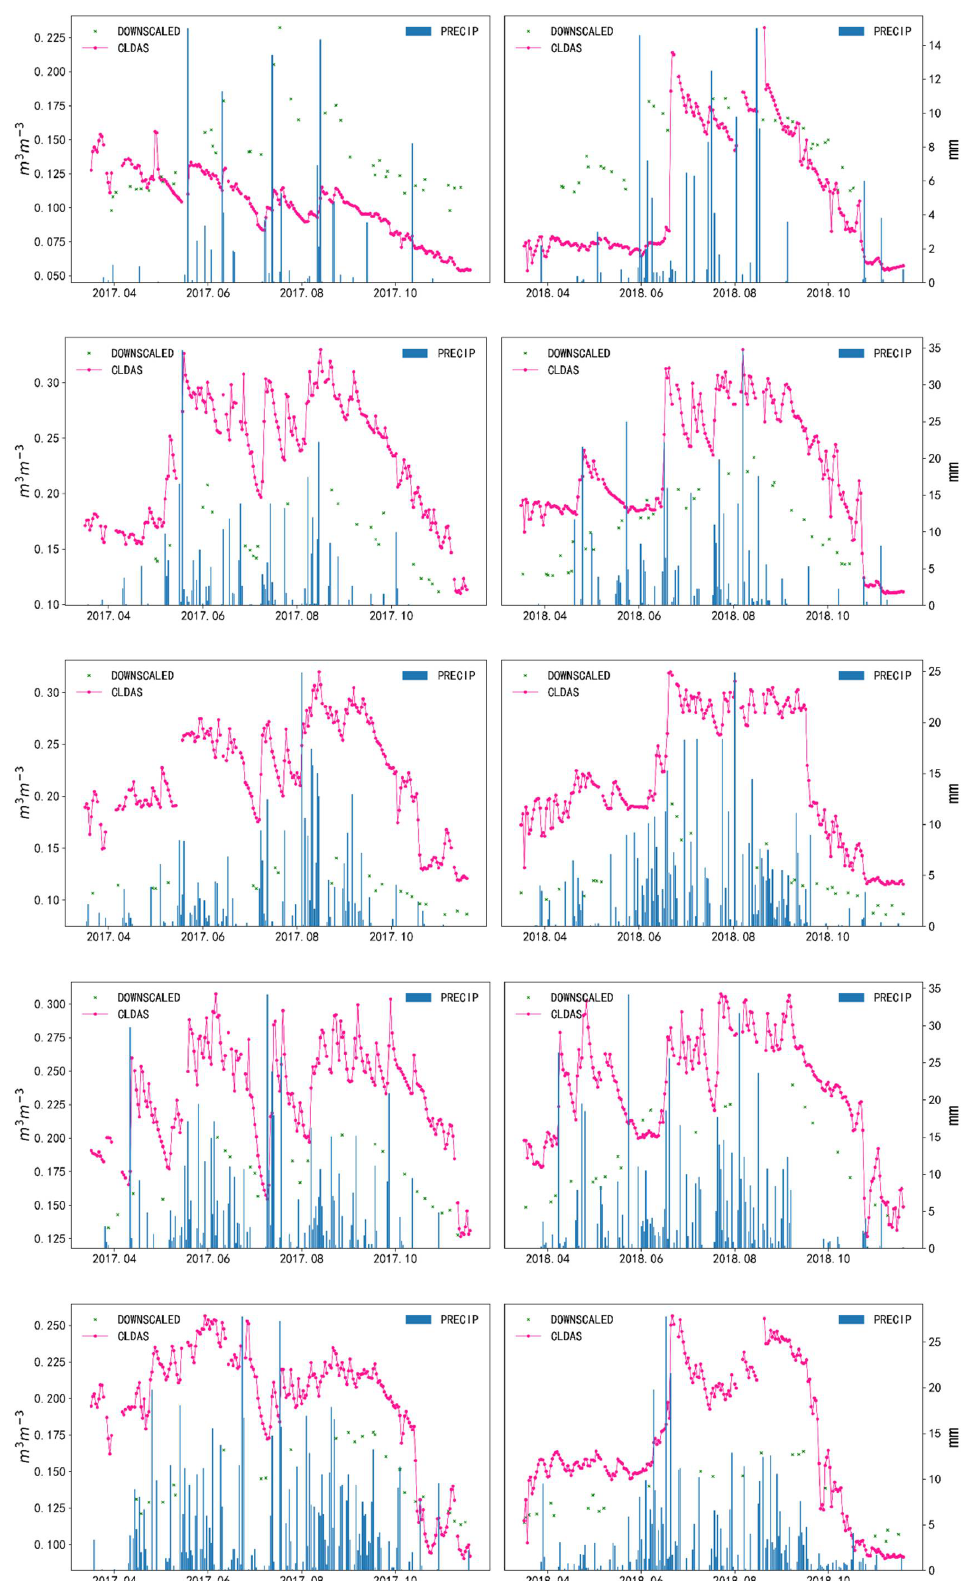
Figure 10. Daily precipitation, downscaled SM, and CLDAS SM over time for seven ground precipitation stations (Yeniugou, Xiaozaohuo, Dachaidan, Chaka, Wudaoliang, Xinghai,